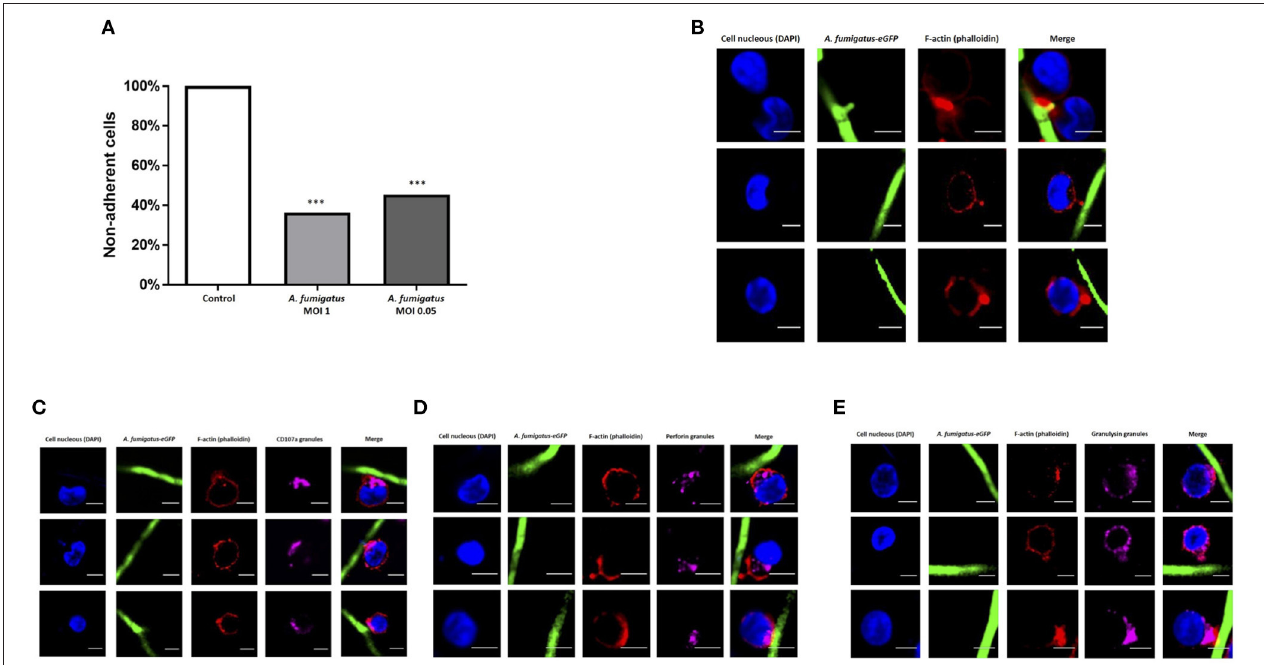
FIGURE 2 | NK cell adhesion to A. fumigatus leads to F-actin accumulation at the immune synapse and granule polarisation (A) . NK cells strongly adhere to A. fumigatus when co-incubated with the fungus in vitro . Primary human NK cells were incubated with A. fumigatus overnight. After the incubation period cells